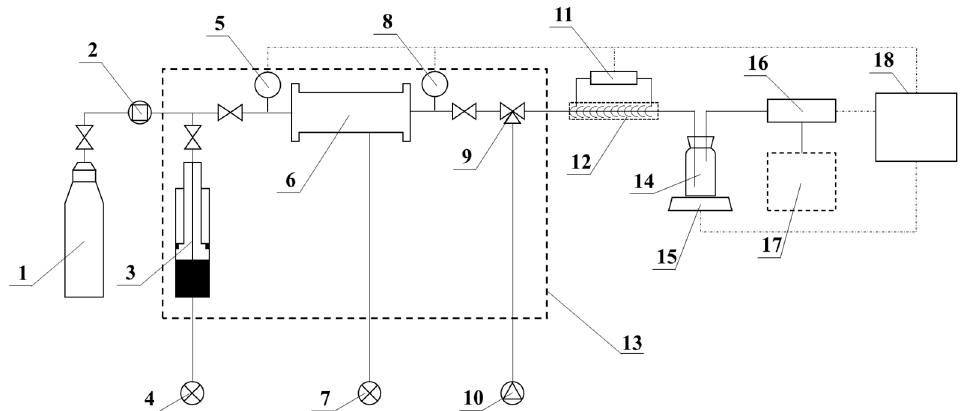
Figure 2. Schematic diagram of the experimental equipment. 1. Nitrogen cylinder; 2. Gas booster